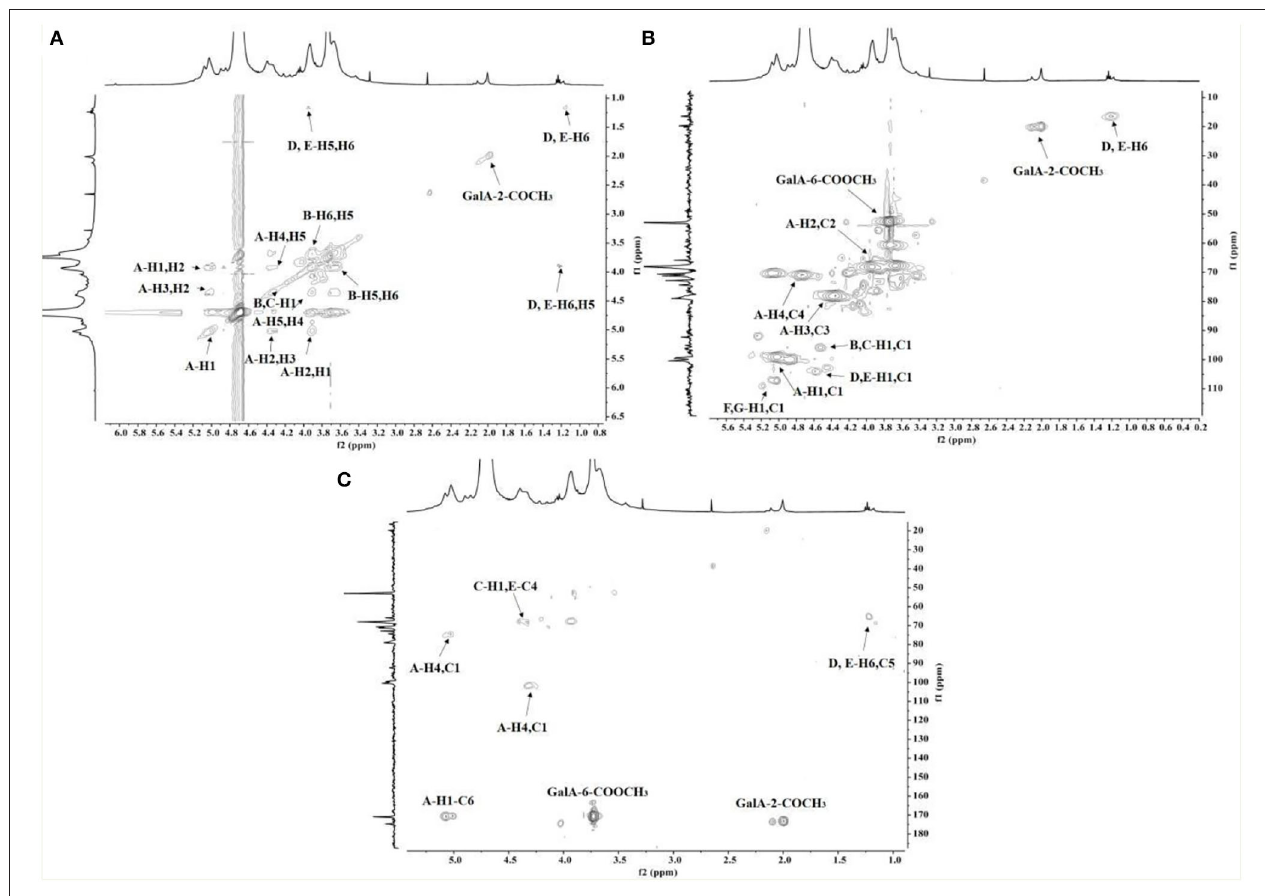
FIGURE 5 | Structure schematic diagram of RCHP-S.